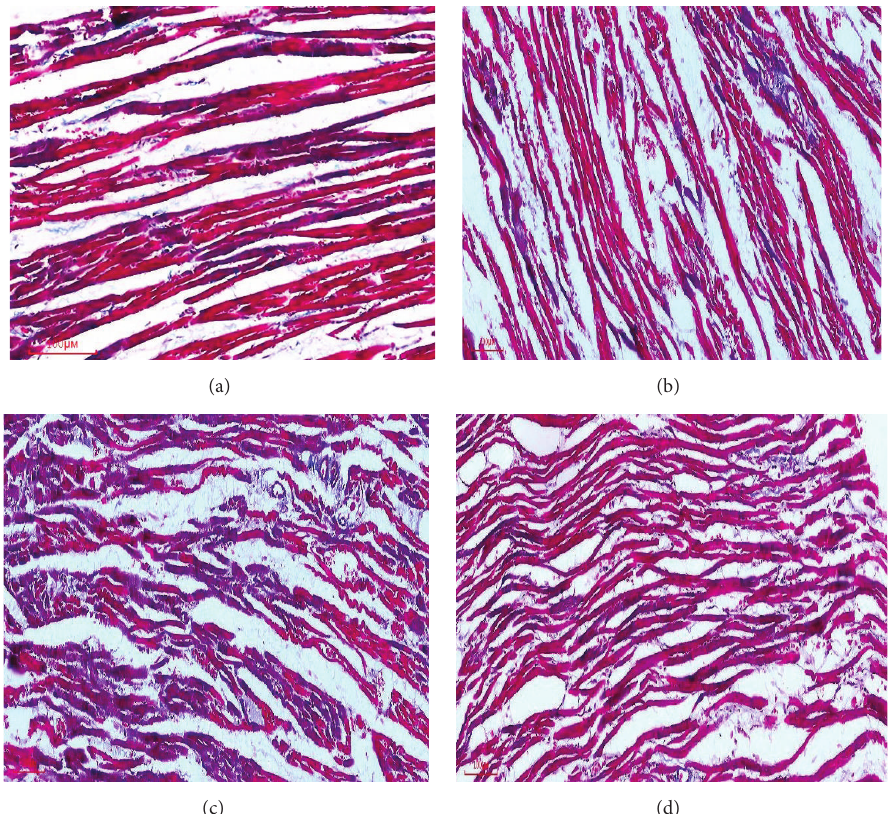
Figure 1: The result of collagen detection by Masson-staining (200). (a) Control, (b) DM4W, (c) DM8W, and (d) EtOH + DM8W.